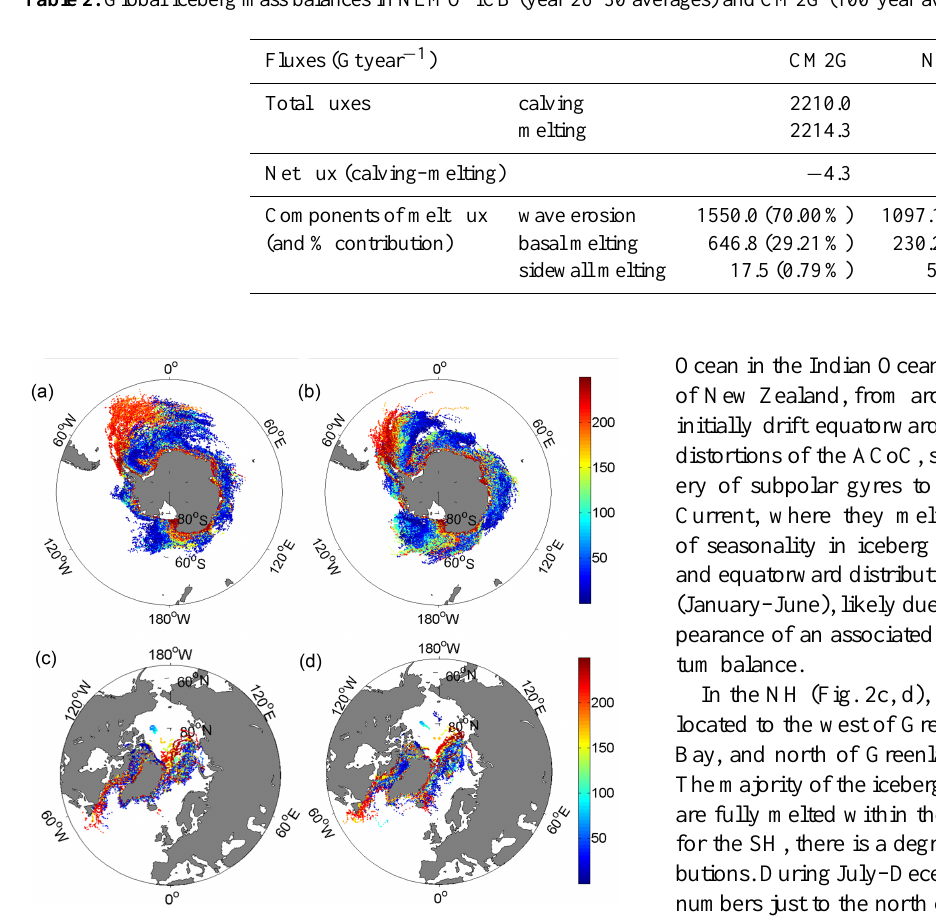
Table 2. Global iceberg mass balances in NEMO–ICB (year 26–30 averages) and CM2G (100-year averages).